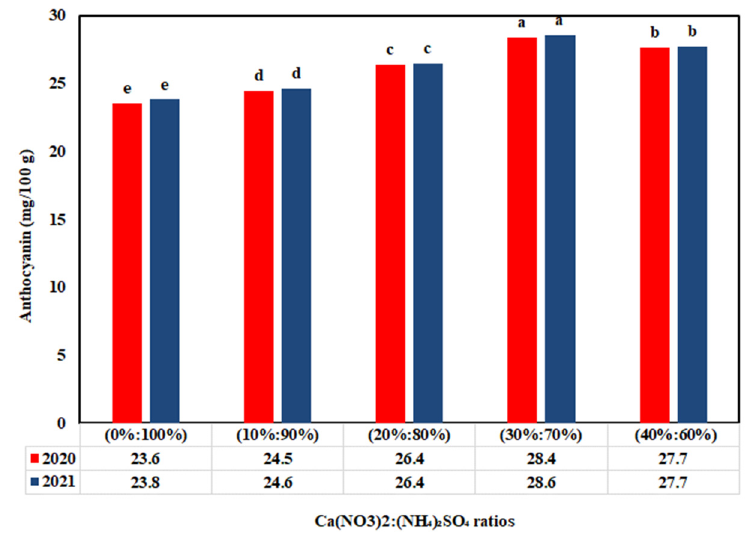
Figure 3. The impact of Ca(NO 3 ) 2 :(NH 4 ) 2 SO 4 ratios on anthocyanin of the pomegranate fruits of cv. ‘Wonderful’ in 2020 and 2021 seasons. Significant differences ( p < 0.05) are denoted by values in the same column that are marked with distinct letters.